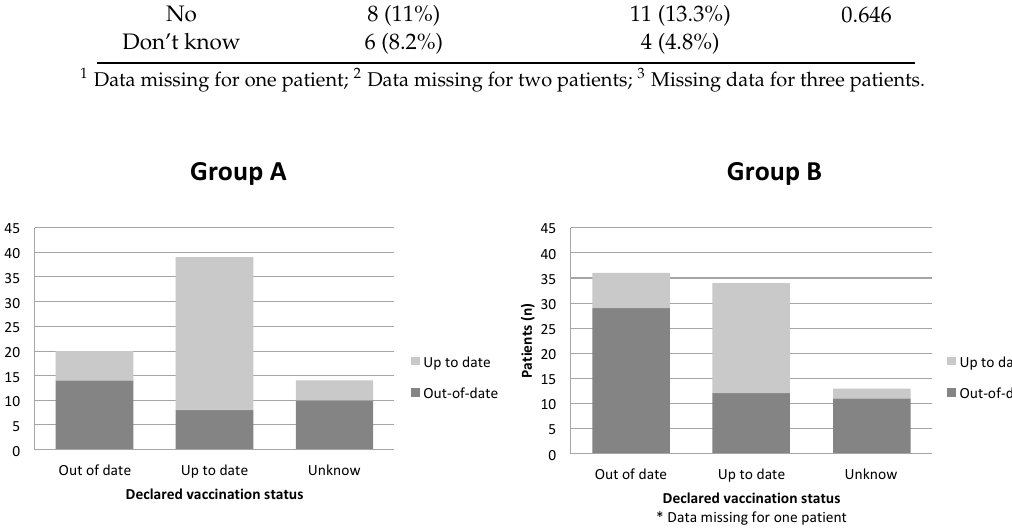
Figure 3. Correspondence between declared and actual diphtheria tetanus and inactivated polio vaccine (DT-IPV) vaccination status at inclusion in the HOSPIVAC study.